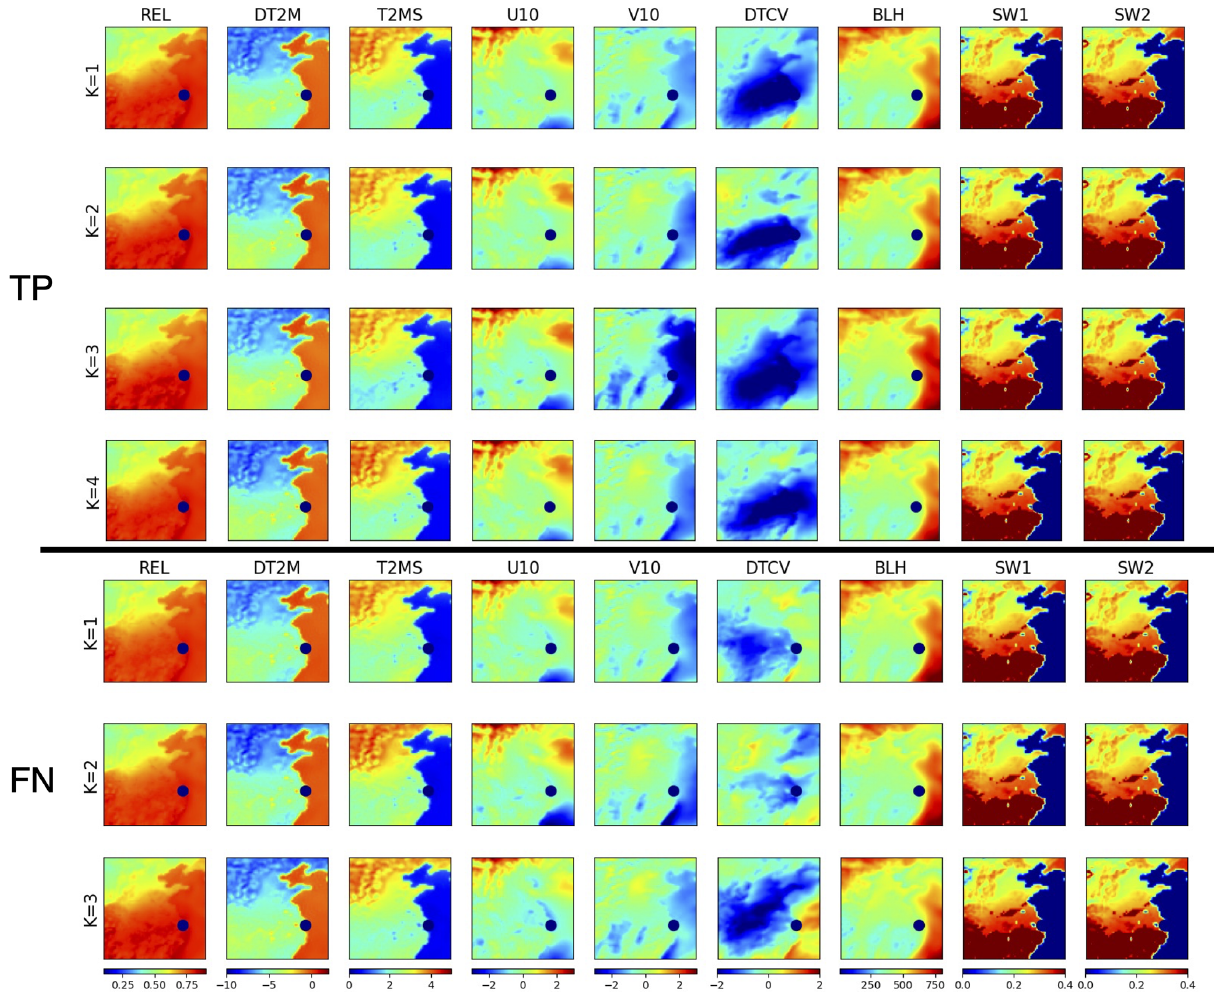
Figure 9. The same as Fig. 8 except for Shanghai with four clusters for TP outcomes and three clusters for FN